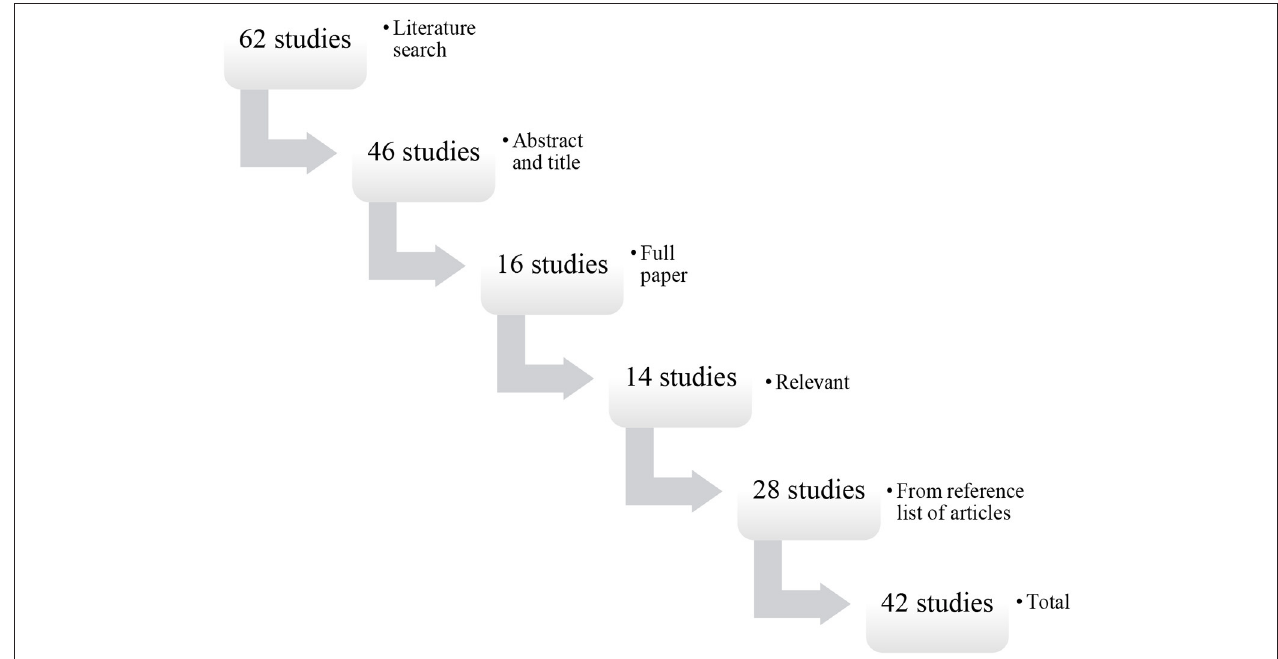
FIGURE 1 | Flow diagram of the search and selection